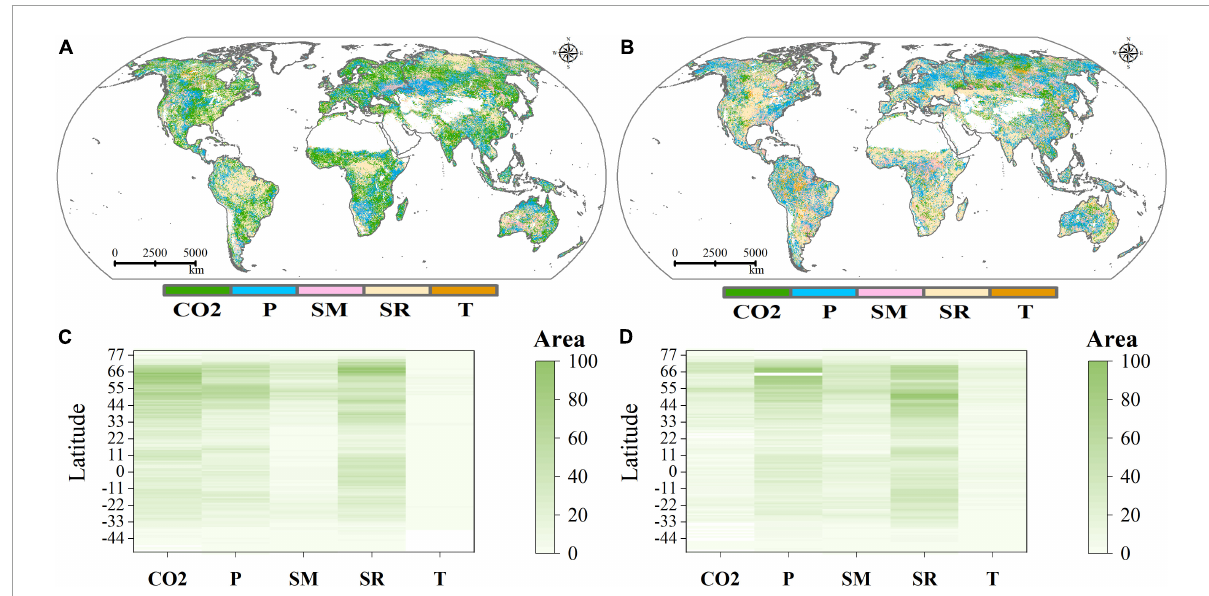
FIGURE3 (A) The main controlling factors and (B) the main load controlling factor influencing the NEP. The five driving factors include CO 2 concentration, T, P, SR, and SM. (C,D) The contributions of the five driving factors at latitudes of 55 ◦ S–80 ◦